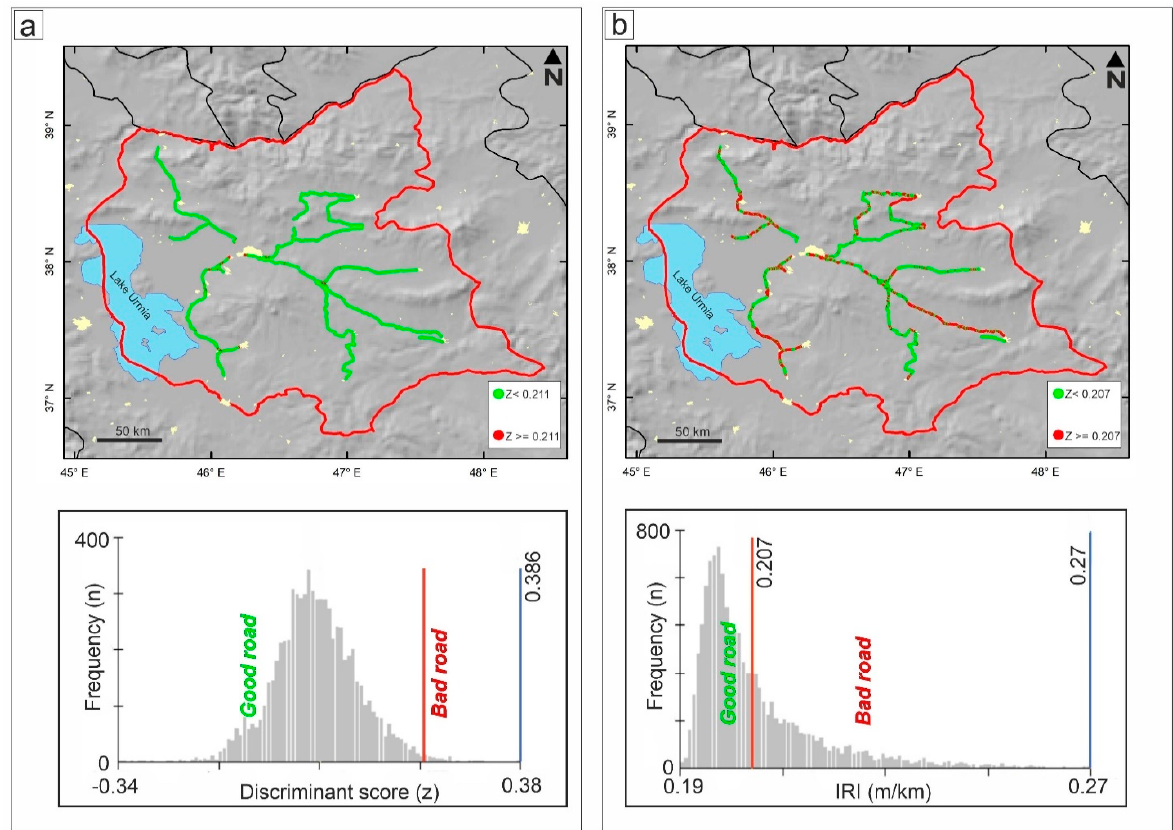
Figure 6. Overall accuracy of the OIF and norm R results using different window sizes.